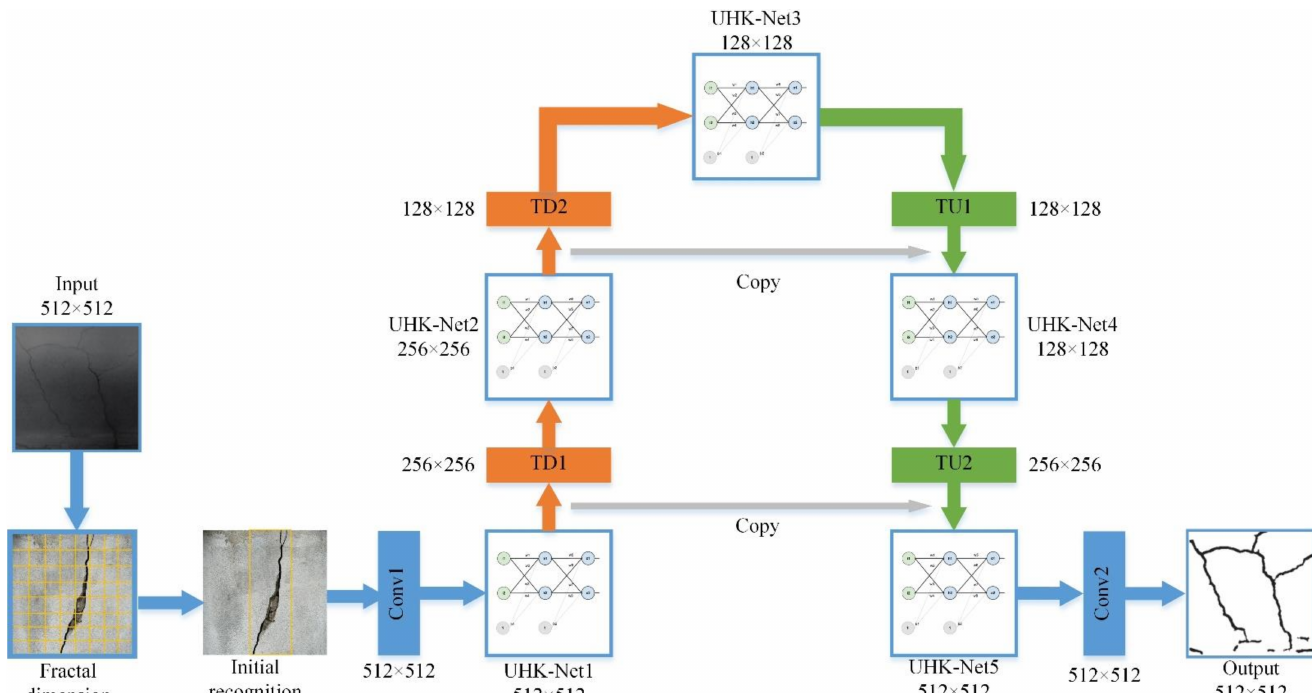
Figure 4. UHK-Net network